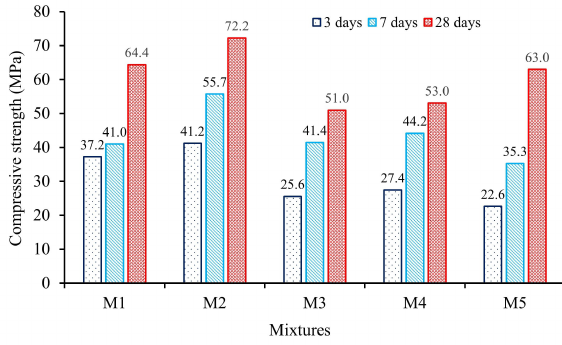
Fig. 4. Splitting tensile strength of all mixtures.